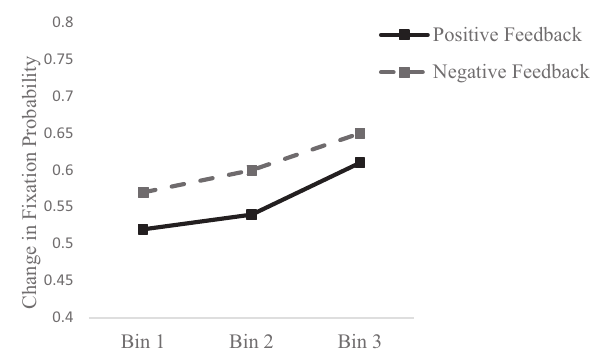
or an interaction of Bin and Feature , F (6, 12) = 2.03, p = 0.123, η 2 p = 0.1, were found (see Figure 3 , right).